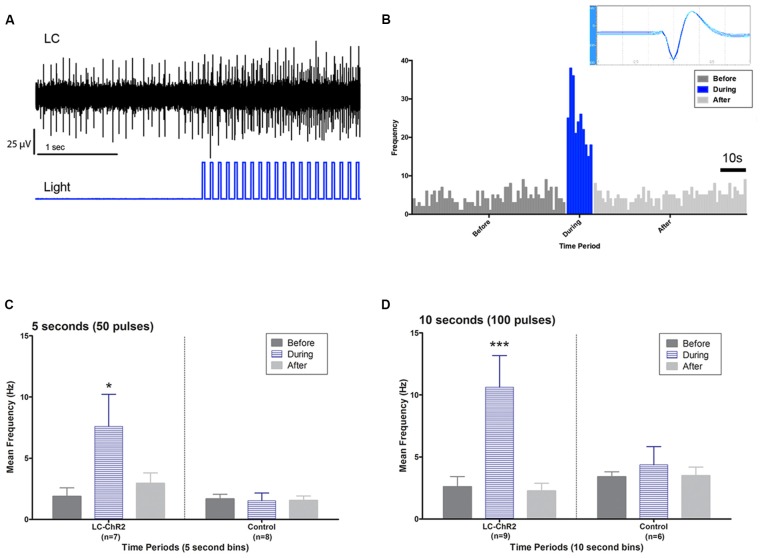
Light activation of anatomically identified LC neurons. (A) Oscilloscope recording showing LC units during baseline and during light pulse train activation. Note activation continuing between pulses and the recruitment of additional units. (B) LC unit waveform cut by Datawave algorithm (inset) and firing pattern plotted as a histogram before, during and after a 10 s light activation. (C) Group histograms for LC and control units during a 5 s light activation protocol. (D) Group histograms for LC and control units during a 10 s light activation protocol. Single asterisk, p < 0.05; triple asterisks, p < 0.001.